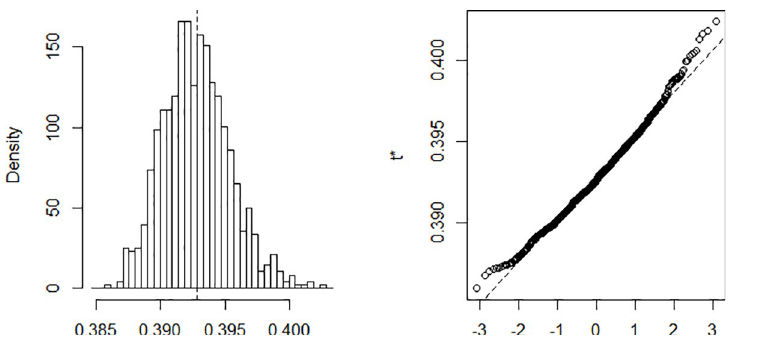
Fig 3. Bootstrap distribution of γ